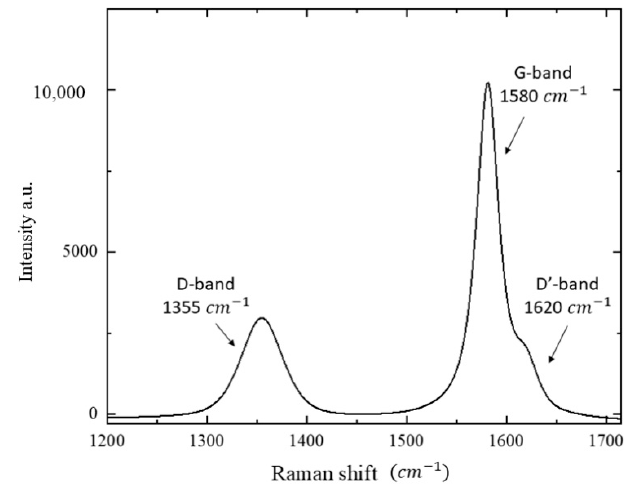
Figure 6. A Raman spectrum of graphite in AhS 209b. The band positions are indicated in the spectrum: G-band at 1580 cm − 1 , D-band at 1355 cm − 1 and D’-band at 1620 cm − 1 .